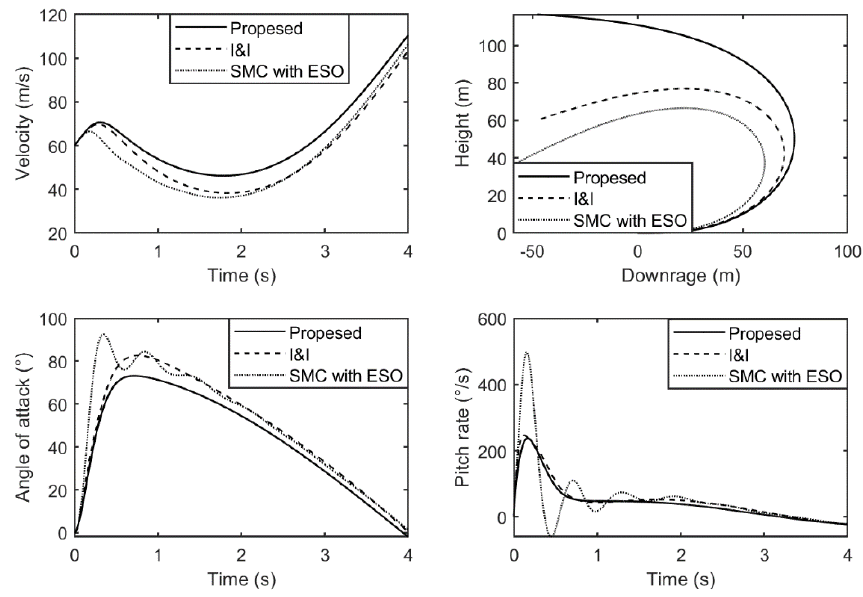
Figure 6. Responses under sliding mode control with ESO.